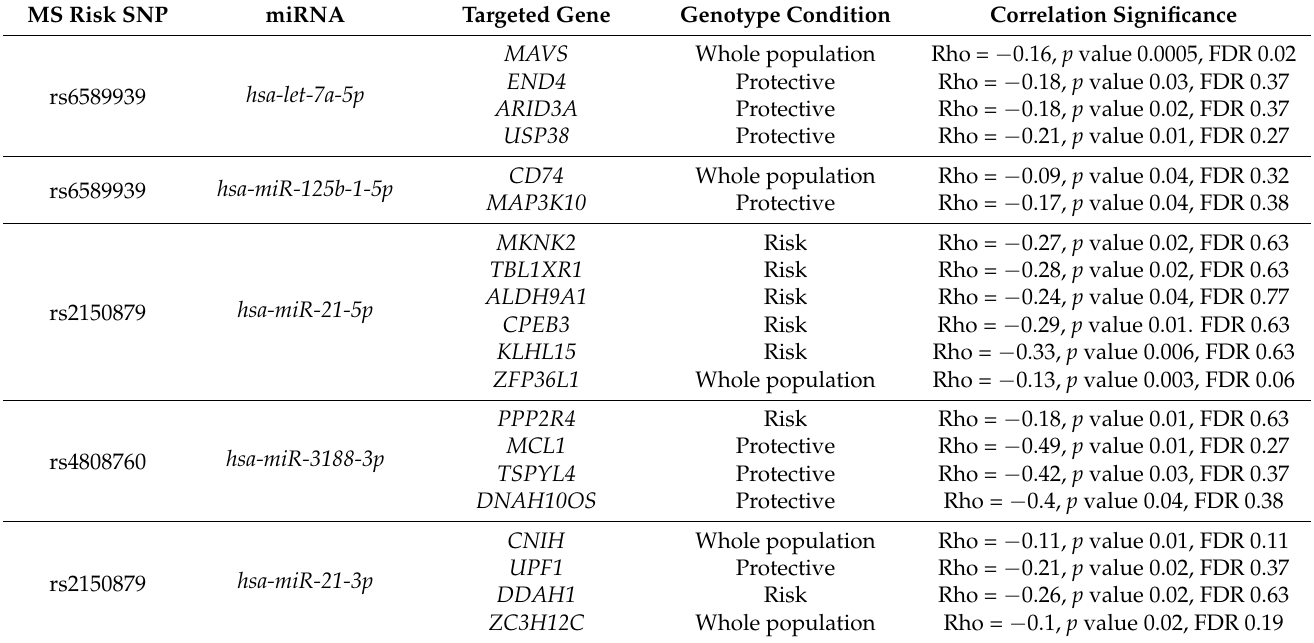
Table 4. MS risk SNP genotype effects on miRNA:mRNA